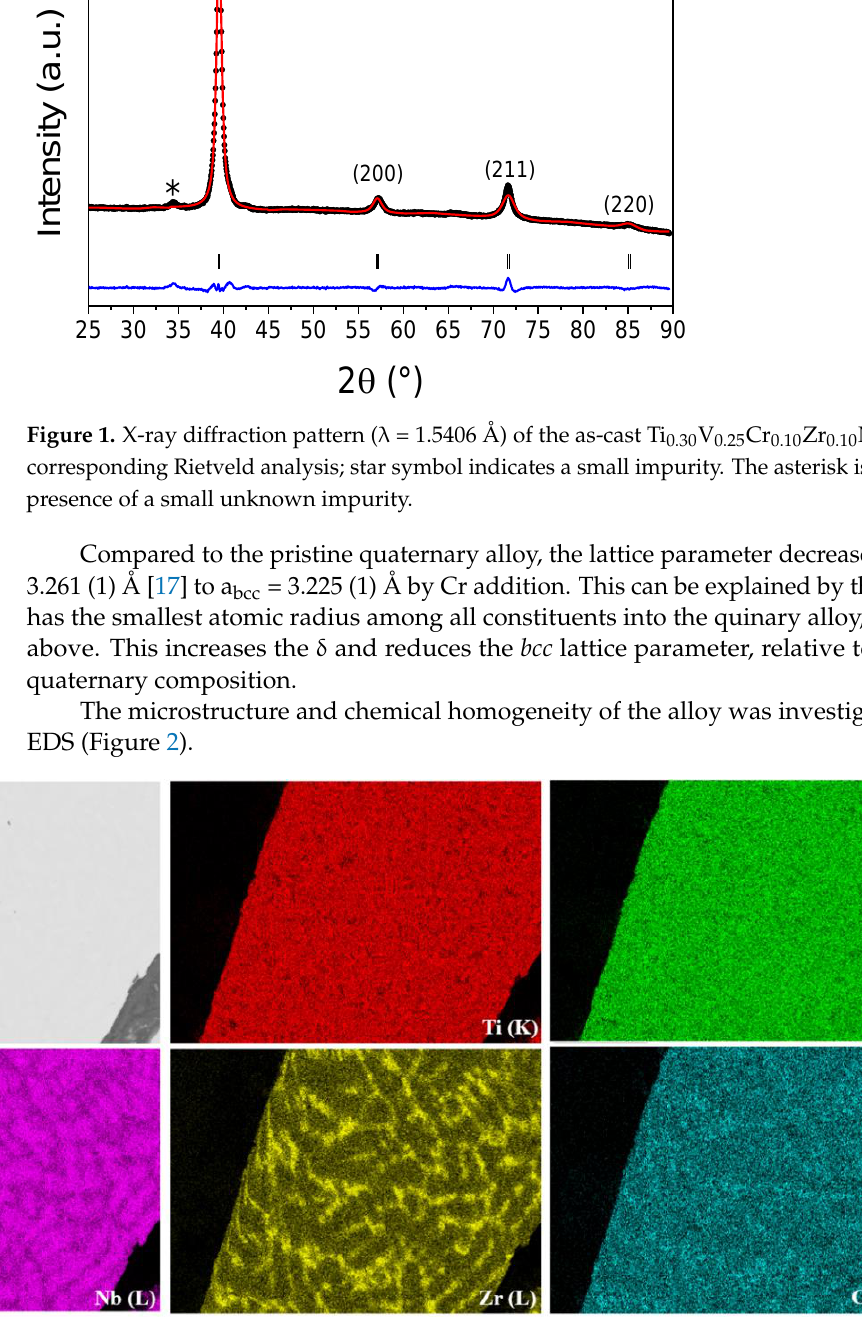
Figure 2. SEM image and related EDS chemical mapping of the as-cast Ti 0.30 V 0.25 Cr 0.10 Zr 0.10 Nb 0.25 alloy.